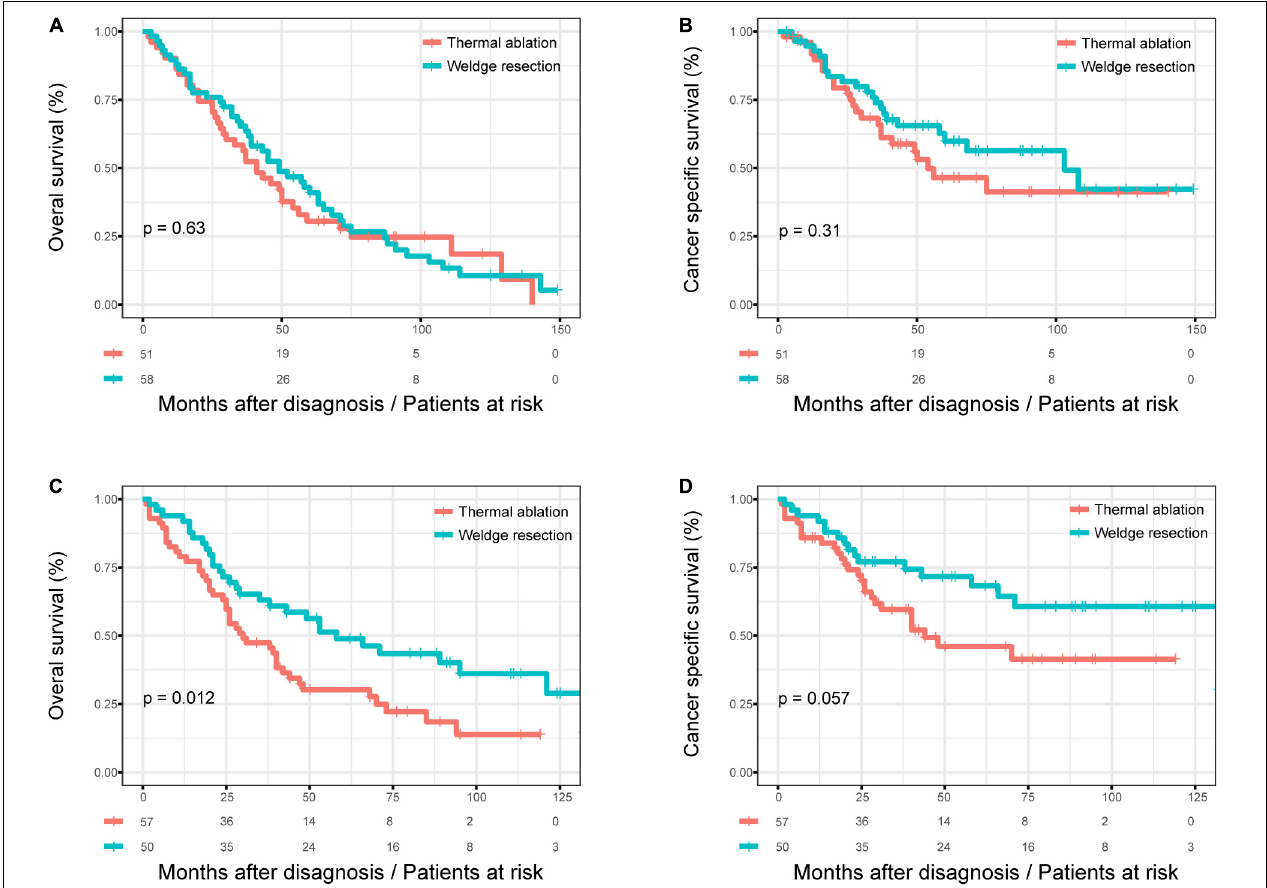
FIGURE 4 | The subgroup analysis of OS and CSS in stage I NSCLC patients who received thermal ablation or wedge resection. (A) The OS curve of stage I NSCLC patients > 75 years who received thermal ablation or wedge resection after PSM ( χ 2 = 0.233, p = 0.63). (B) The CSS curve of stage I NSCLC patients > 75 years who received thermal ablation or wedge resection after PSM ( χ 2 = 1.04, p = 0.31). (C) The OS curve of stage I NSCLC patients < 75 years who received thermal ablation or wedge resection after PSM ( χ 2 = 6.384, p = 0.012). (D) The CSS curve of stage I NSCLC patients < 75 years who received thermal ablation or wedge resection after PSM ( χ 2 = 3.633, p =